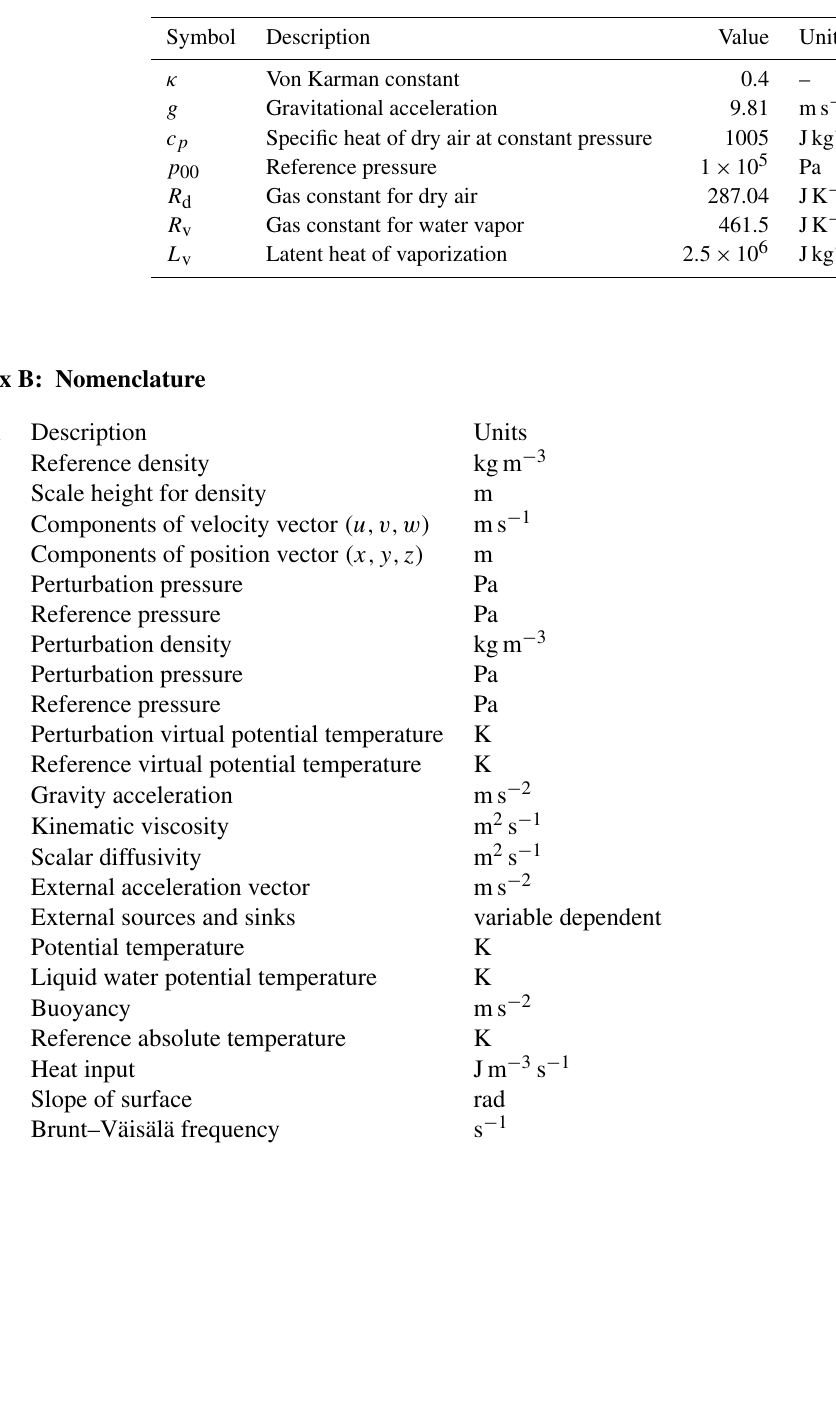
Table A1. Overview of used